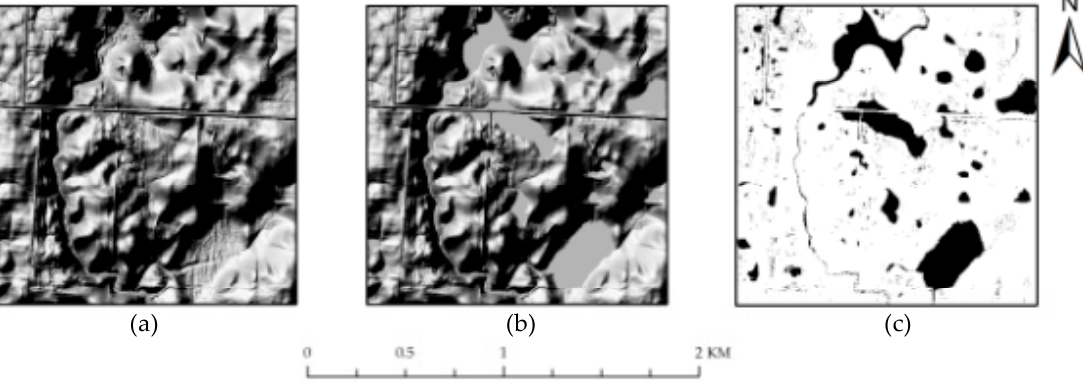
Figure 6. Creation of the depression-filled DEM and identification of surface depressions of a small part of Grant county of Minnesota, USA. ( a ) Hill shading of the original DEM ( b ) Hill shading of the depression-filled DEM. and ( c ) Identified surface depressions.